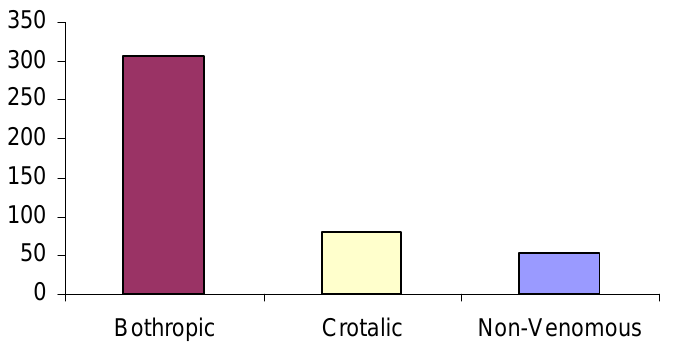
Figure 6: This child showed intense neurotoxicity with palpebral ptosis after being bitten by a Crotalus snake.